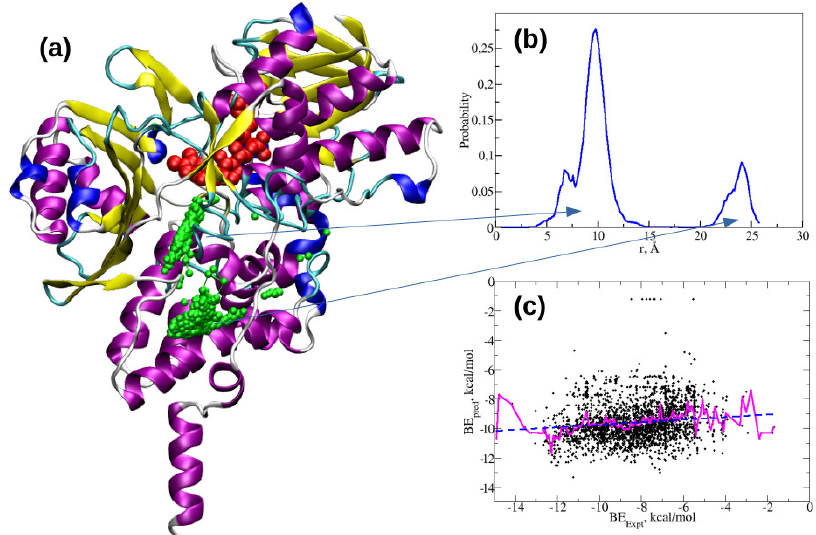
Figure 6. ( a ) Two major binding sites in MAO-B for various ligands; ( b ) the distribution of distances between the FAD-centered N atom and center of mass of ligands; and ( c ) the correlation between the autodock-vina predicted binding free energies and experimental binding free energies for the ligands in substrate cavity